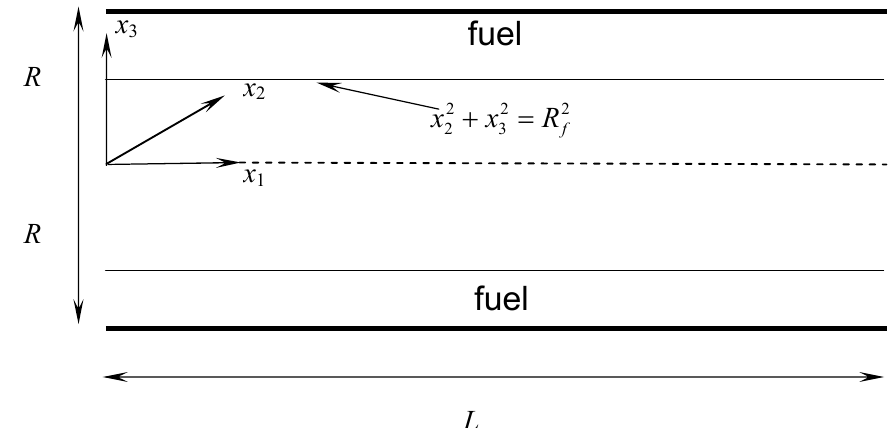
Figure 6. Configuration of a combustion